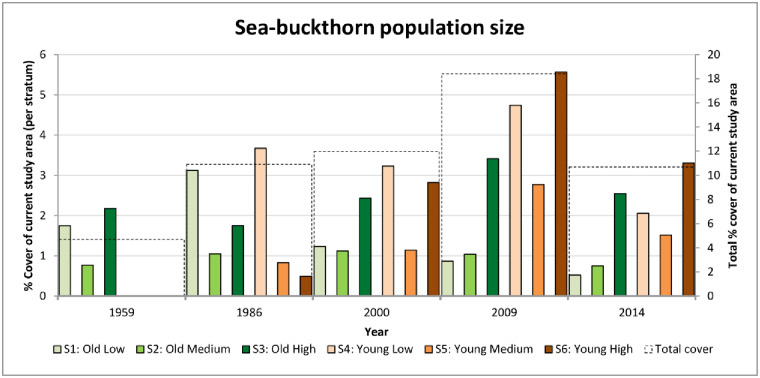
Sea-buckthorn cover (%) in the different strata for each photograph.1 percent equals 1.5 hectares of the study area. The dotted boxes represent the sum of the population cover (%) over all strata.